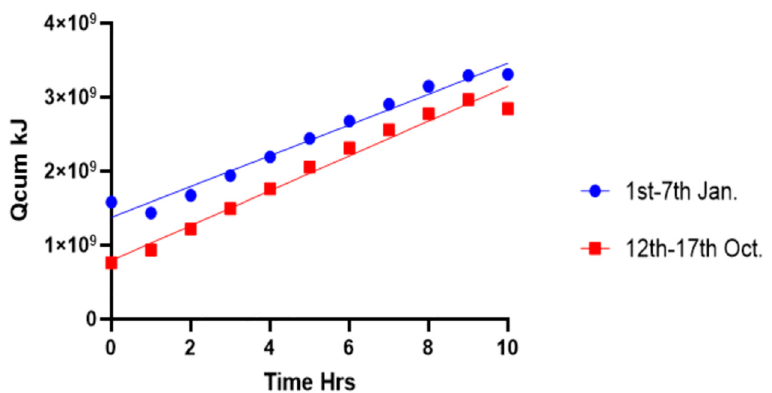
Figure 8. Average cumulative charge over time.